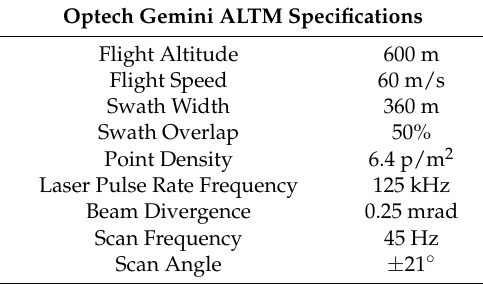
Figure 2. Airborne LiDAR/Laser (ALS)-derived elevation products for the SRS swath. ( a ) Digital Surface Model (DSM) hillshade; ( b ) Digital Terrain Model (DTM) hillshade; ( c ) A digital canopy model (DCM) created by subtracting the DTM from the DSM. Table 1. Optech Gemini Airborne Laser Terrain Mapper (ALTM) specifications for Everglades National Park